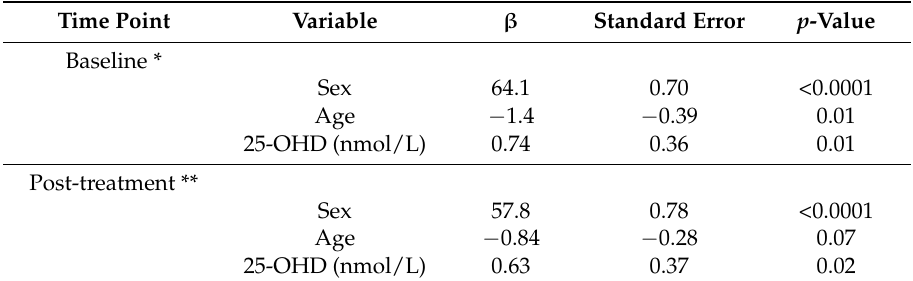
Table 4. Multiple regression analysis with skeletal muscle mass as the dependent variable and sex, age, 25-OHD as independent variable.